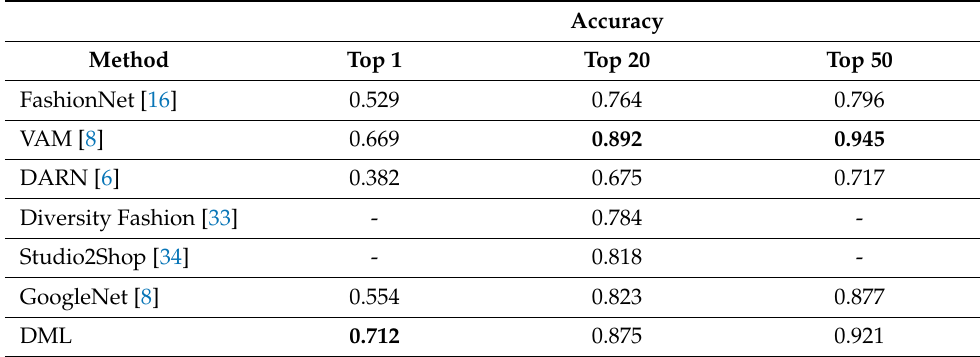
Table 3. Comparison of top-k accuracy rates on the InShop Clothes Retrieval benchmark of the DeepFashion dataset. Bold shows the the best rate.